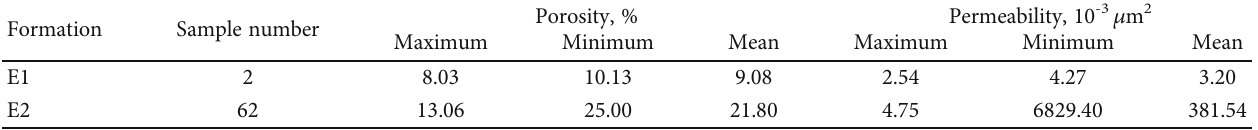
Table 5: Reservoir physical property statistics for core analysis of block Yingmai 7.